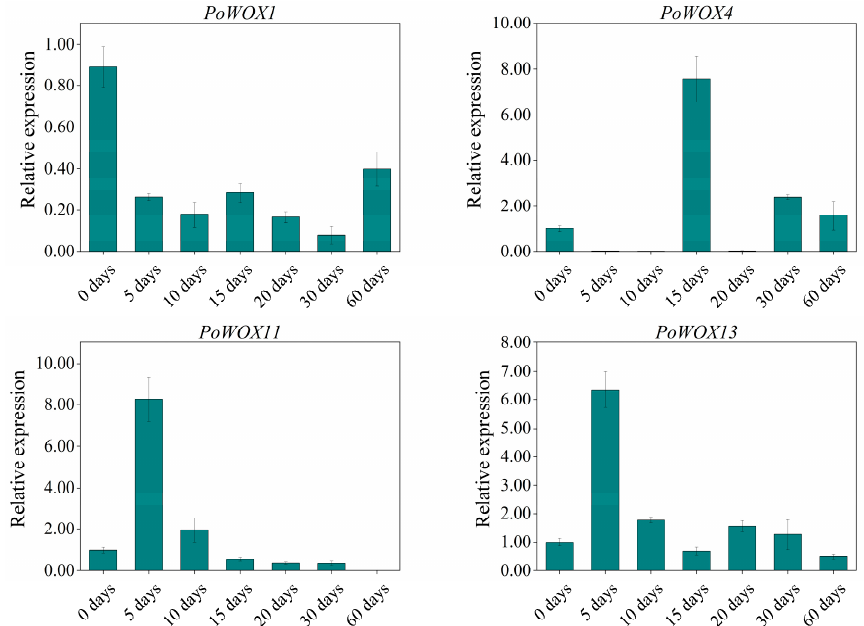
Figure 4. Expression of PoWOX genes of peony in the developmental stage of somatic embryos. Expression levels of peony somatic embryos in seven developmental stages (0; 5; 10; 15; 20; 30; 60 days). The expression of Day 0 peony somatic embryos was the control group.